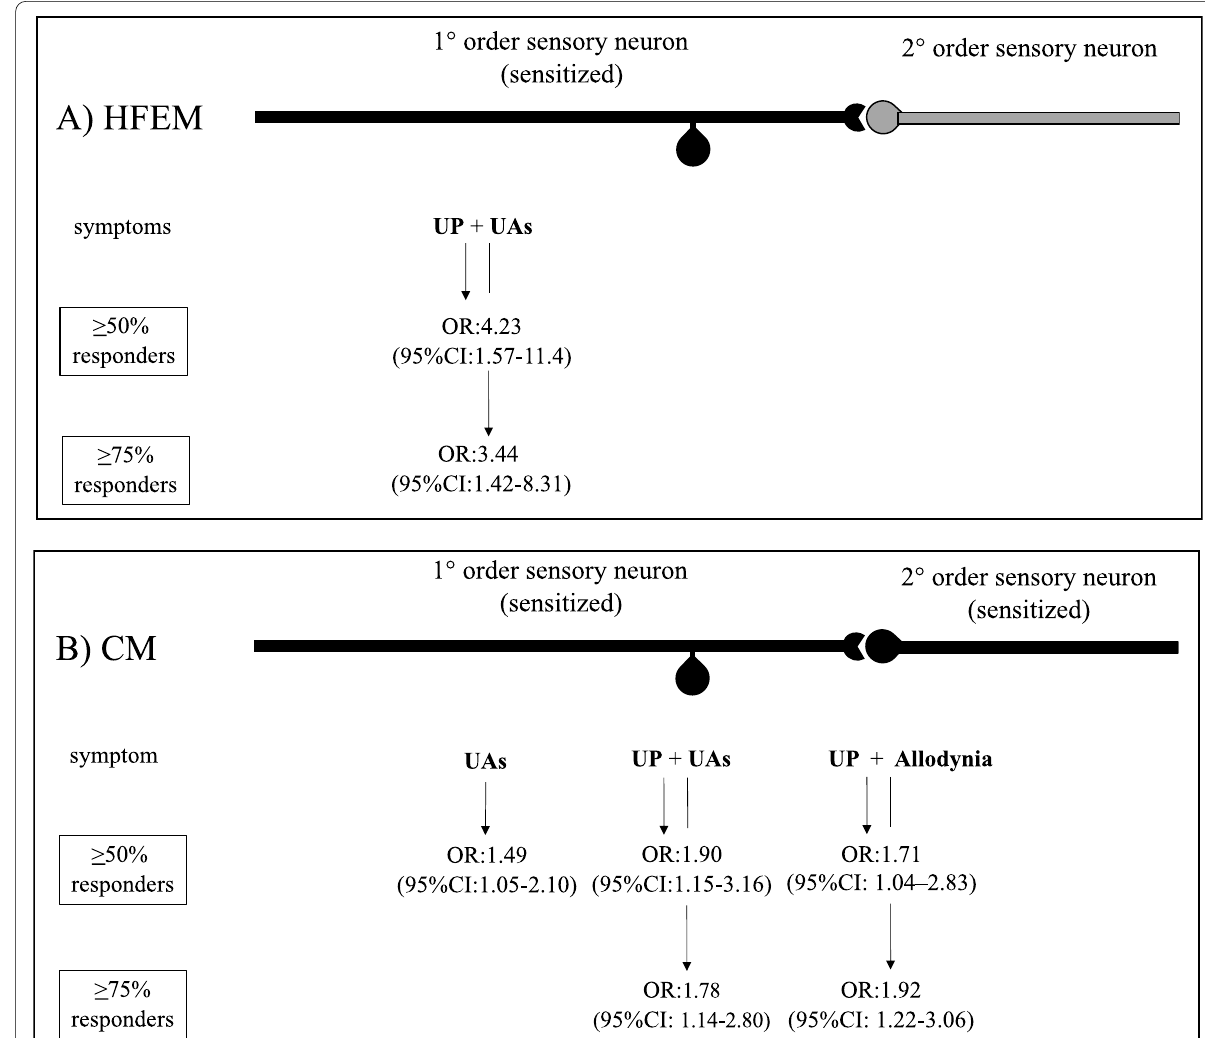
Fig. 1 A In patients with HFEM, unilateral pain (UP) associated with unilateral cranial autonomic symptoms (UAs) – clinical manifestation of CGRP-mediated peripheral sensitization - predict both predict 50 response to antiCGRP mAbs, while UP ≥ - predict 75% ≥